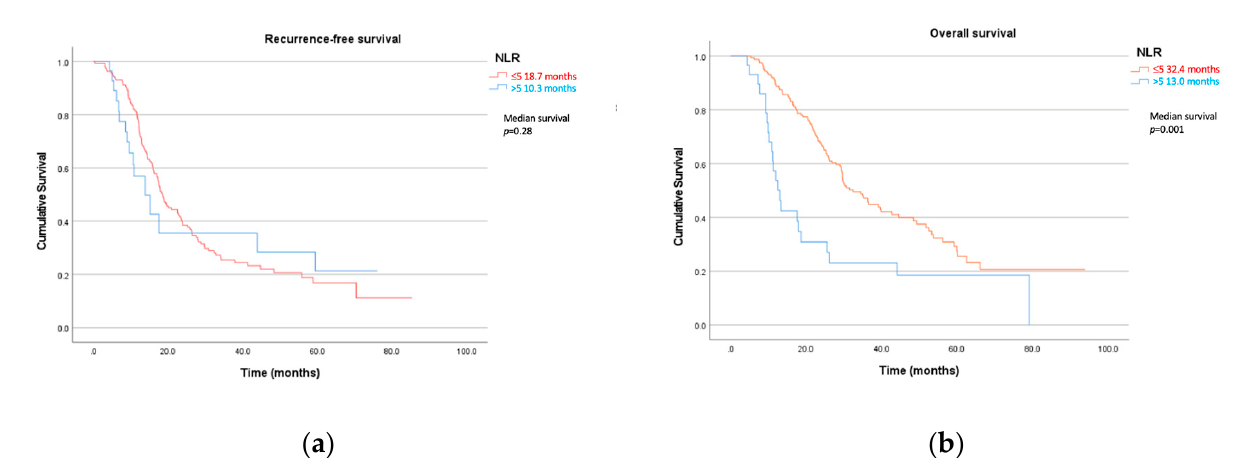
Figure 2. ( a ) Recurrence-free and ( b ) overall survival by neutrophil-to-lymphocyte ratio (NLR). Higher residual tumour was a prognostic marker for overall survival with an increased hazard of 1% for every 1% in remaining viable tumour ( p = 0.023, HR 1.01). Table 4. Clinical and inflammatory prognostic markers of overall